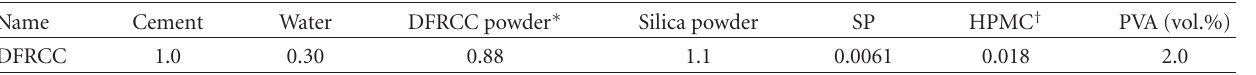
Table 3: Mixture proportion of extrusion DFRCC